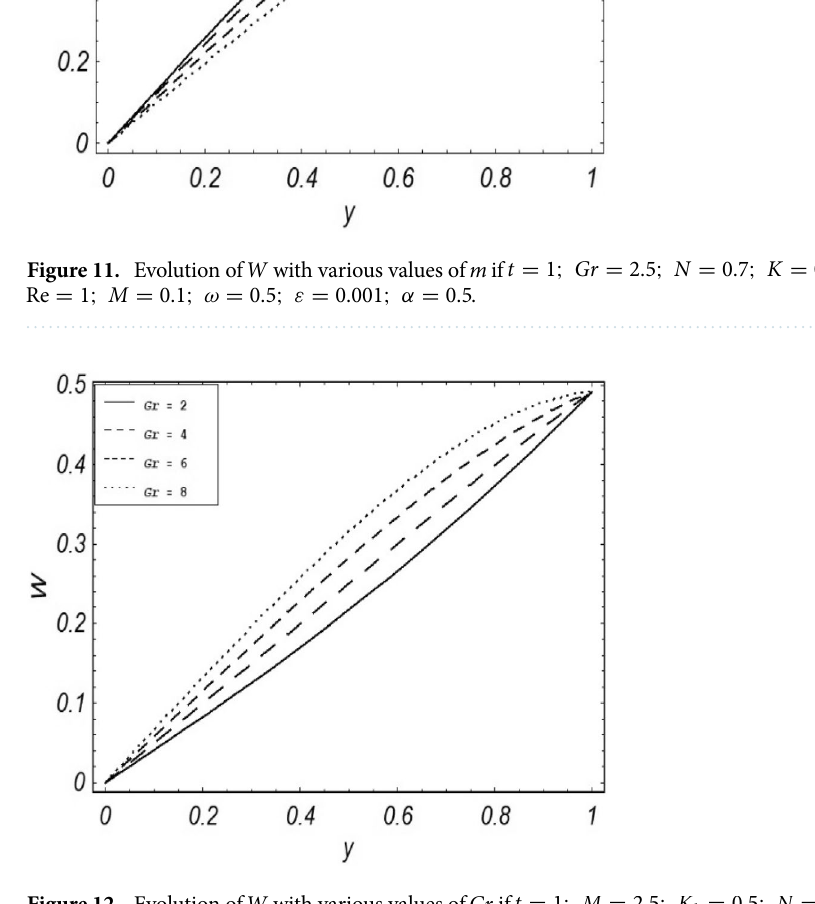
Figure 12. Evolution of W with various values of Gr if t = 1 ; M = 2.5 ; K 1 = 0.5 ; N = 1 ; η = 0.2 ; m = 0.5